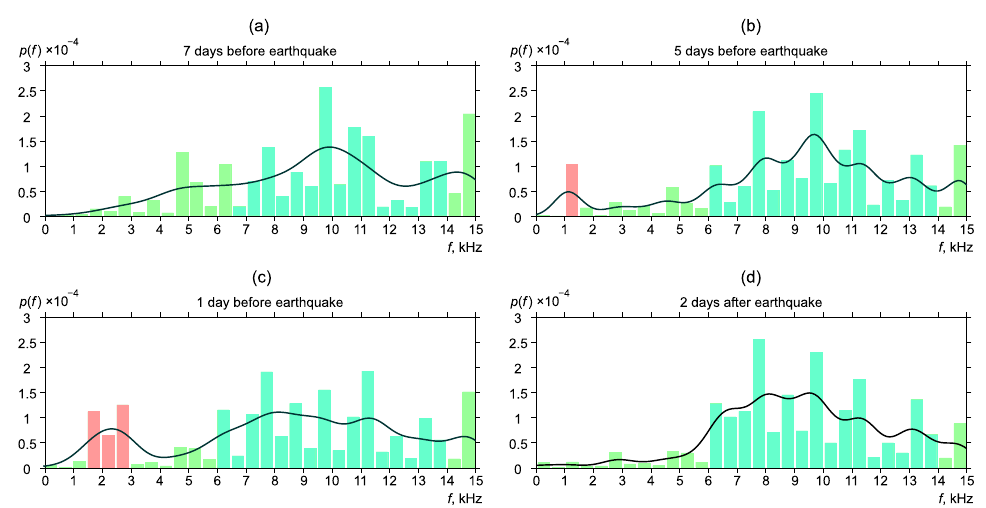
Figure 9. Dynamics of the probability density of distribution of the most powerful frequencies of geoacoustic pulses before and after the earthquake No. 4.